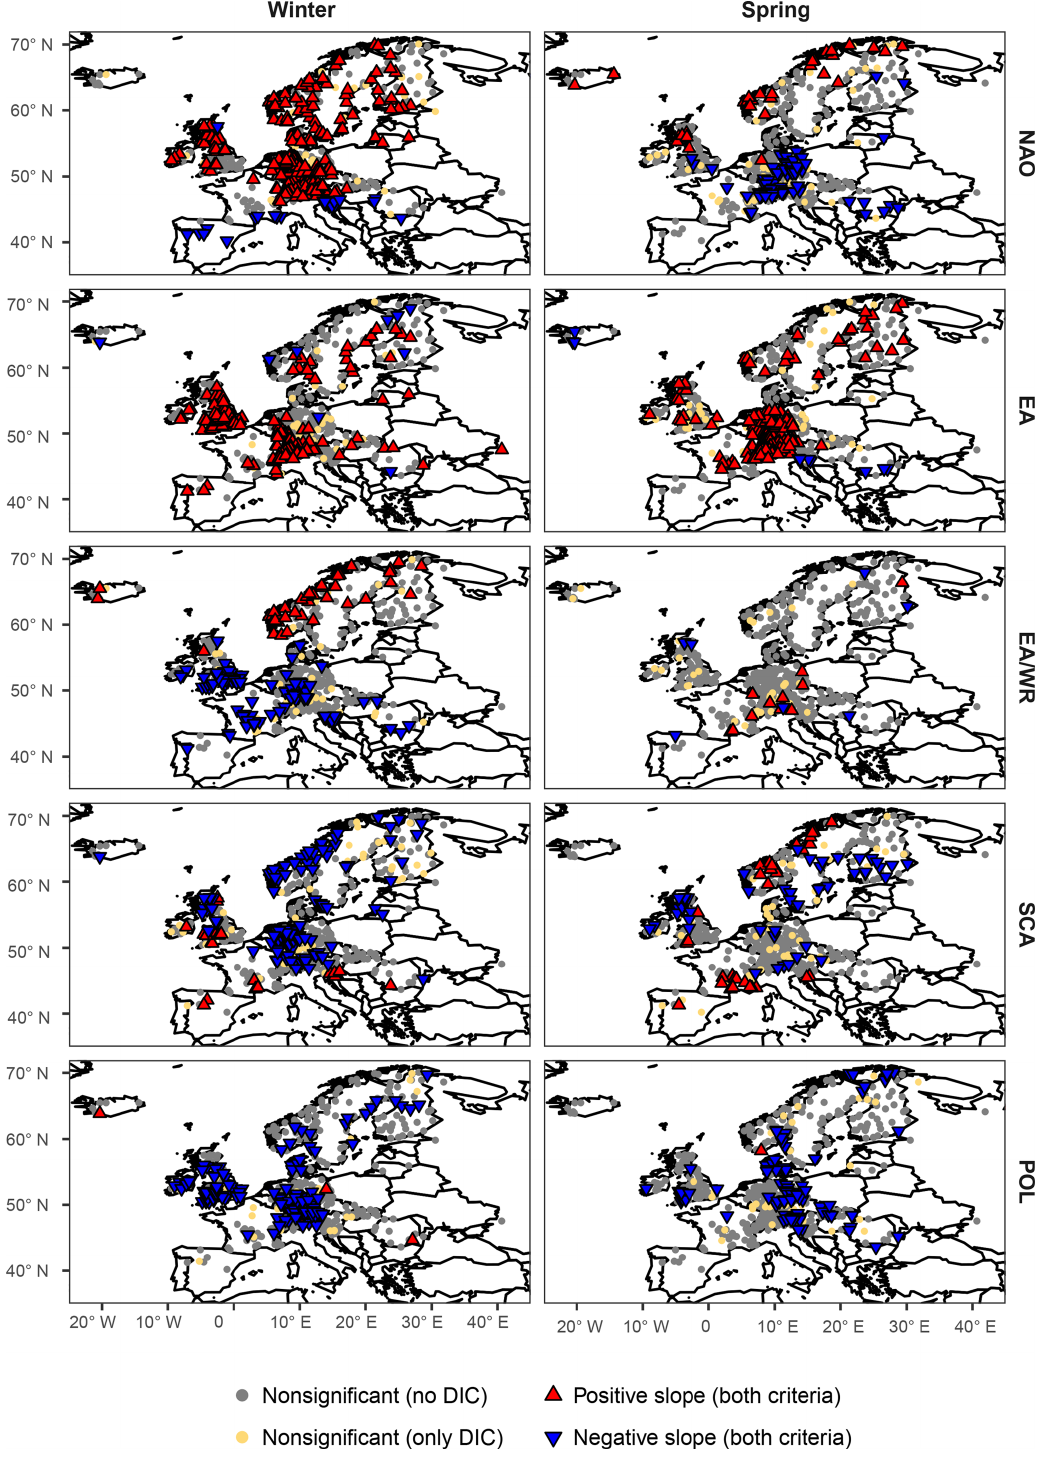
Figure 1. Results comparing the climate-informed and the classical GEV models for all covariates examined for the winter and spring season. Nonsignificant models preferred only by the DIC (yellow points) are plotted on top of stations for which climate-informed models were not chosen by any of the two criteria (grey points). Preferred climate-informed models chosen by both criteria (blue and red triangles) are illustrated on top of the other models so that they can be better